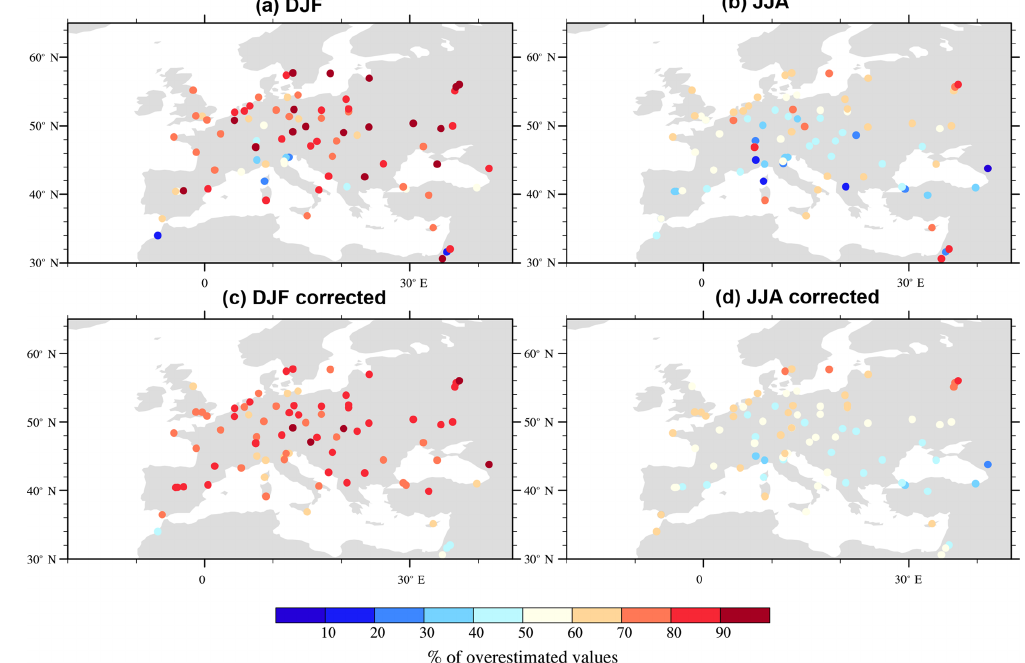
Figure 3. Percentage of simulated daily mean IWV values which overestimate the GPS ones (a) in winter and (b) in summer. Simulated values are taken from five models at 50km resolution (LMD50, IPSL50, CNRM50, CMCC50, UCLM50) regridded to the ERAI grid. Panels (c) and (d) are the same as (a) and (b) but for height-corrected values. Table 5. Summertime interannual correlation between IWV and Q2 at GPS stations. In bold, the mean value for each model, followed by min and max values. The other values in the table corresponds to the standard deviation of the difference in correlation between two models.